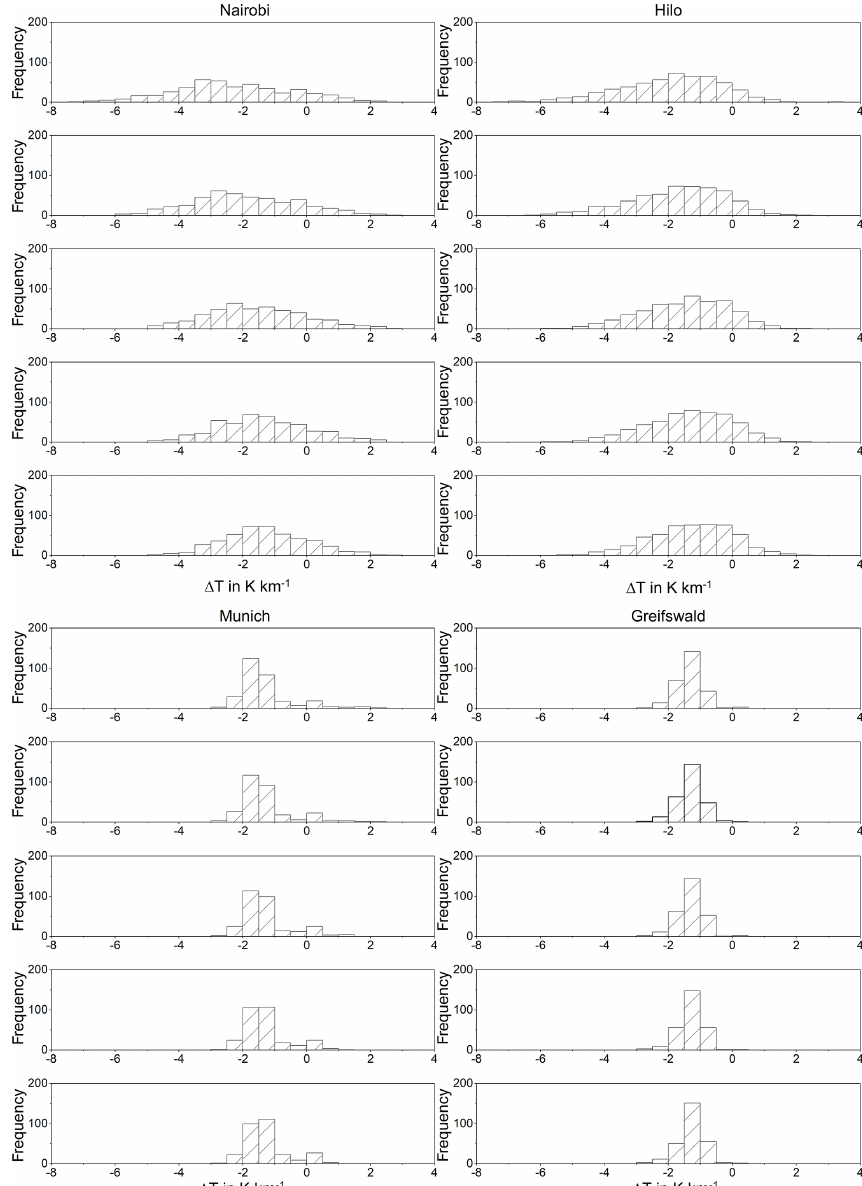
Figure 9. Histograms of optimal lapse rates for tropopause determination from coarsely resolved temperature profiles for four stations. Vertical resolutions vary from 1km to 5km (from top to